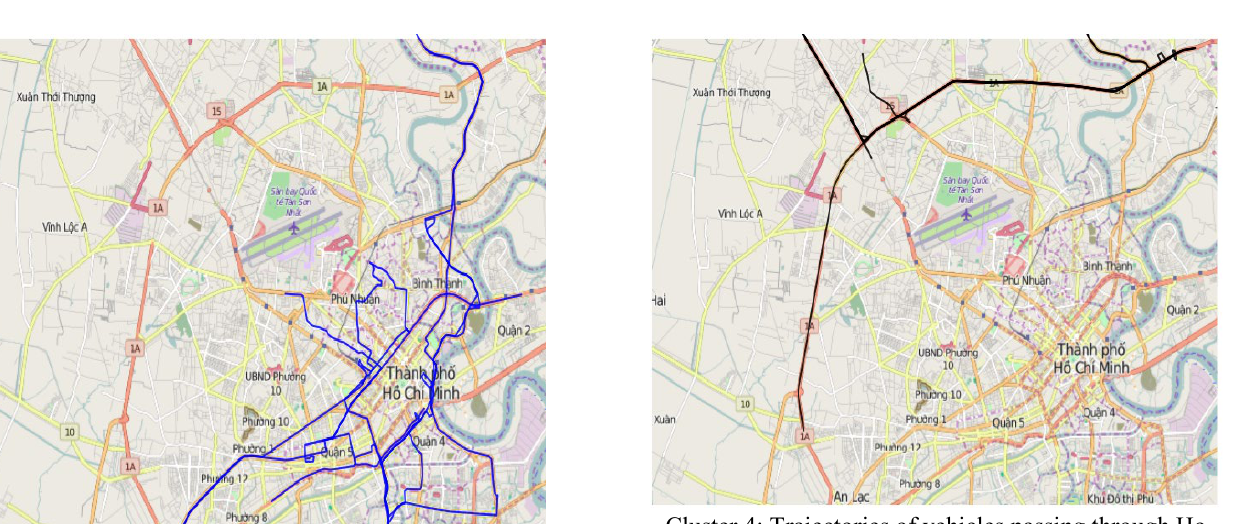
Fig.8. Clustering results obtained from Ho Chi Minh City Dataset: difference between private and public transport.